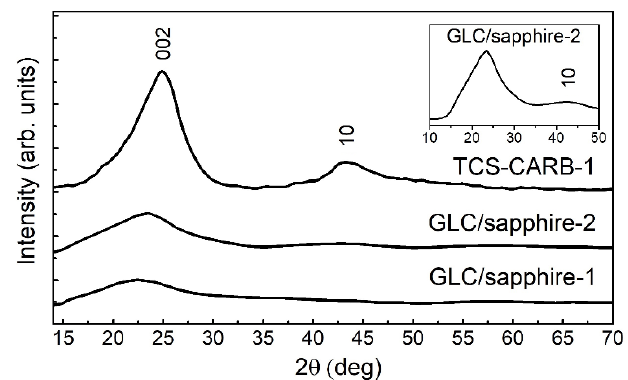
Figure 2. XRD patterns of the target material and carbon films on sapphire substrate.